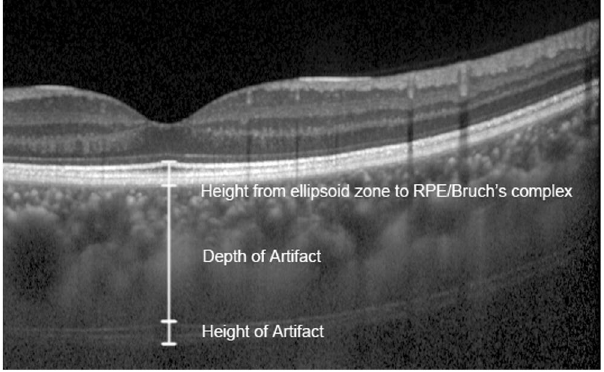
Figure 4. The linear artifact line measured by EDI-OCT. The height from the ellipsoid zone to RPE/Bruch’s complex and the depth and height of the linear artifact are demonstrated. RPE: retinal pigment